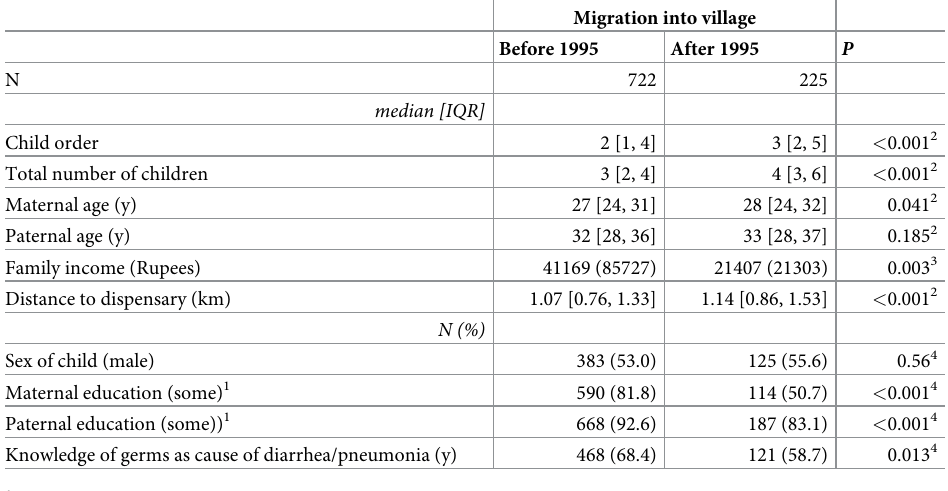
Table 1. Household and demographic characteristics of the population (N = 959